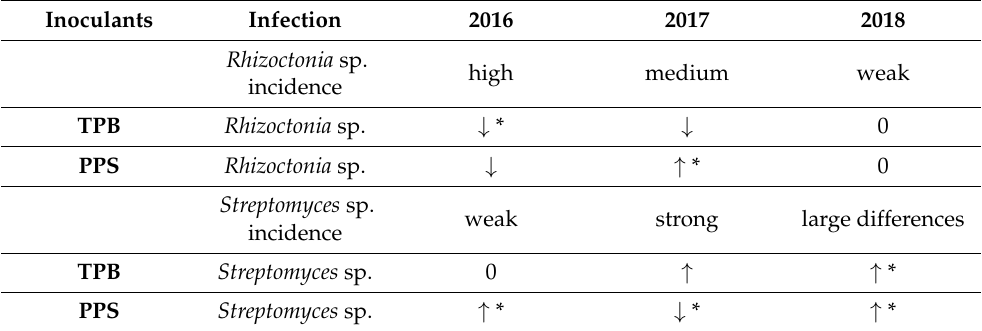
Table 4. Summary of the effects of the two biofertilizer inoculant combinations on the number